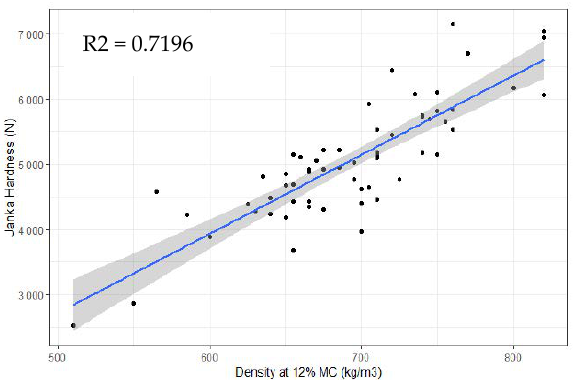
Figure 6. Correlation between hardness and density for E. obliqua .